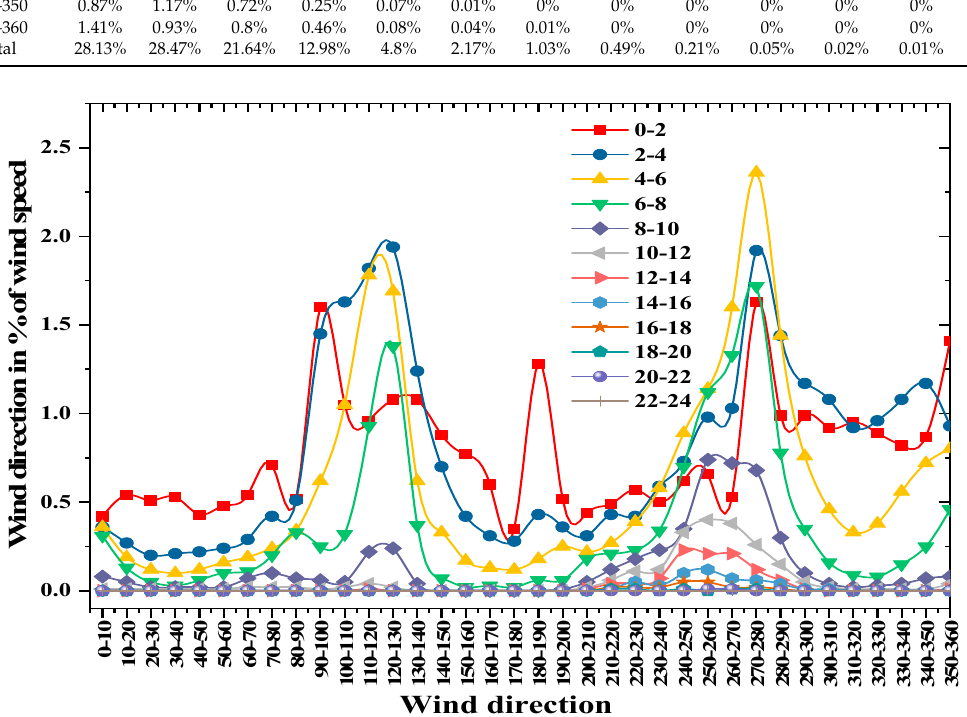
Figure 9. Distribution of the wind speed based on the wind direction.